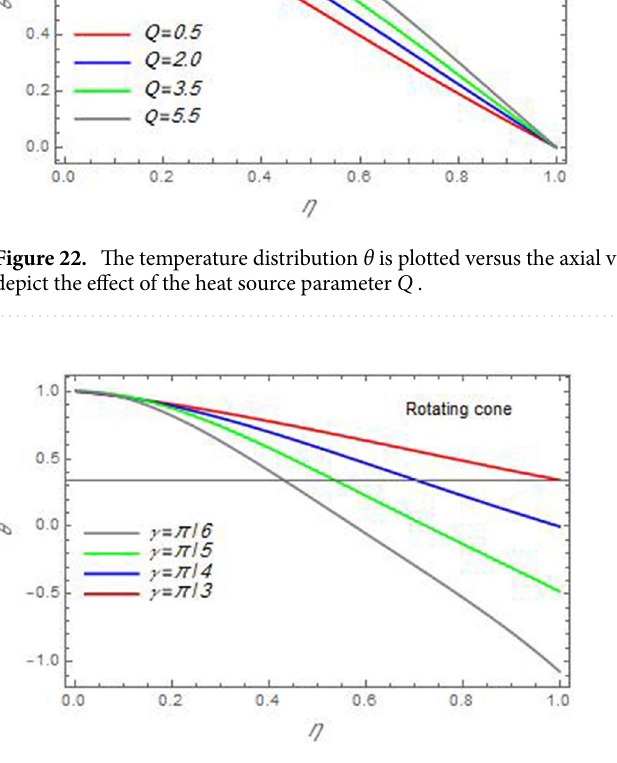
Figure 23. The temperature distribution θ is plotted versus the axial variable η in the case of stationary disc to depict the effect of the angle between the disc and cone γ .